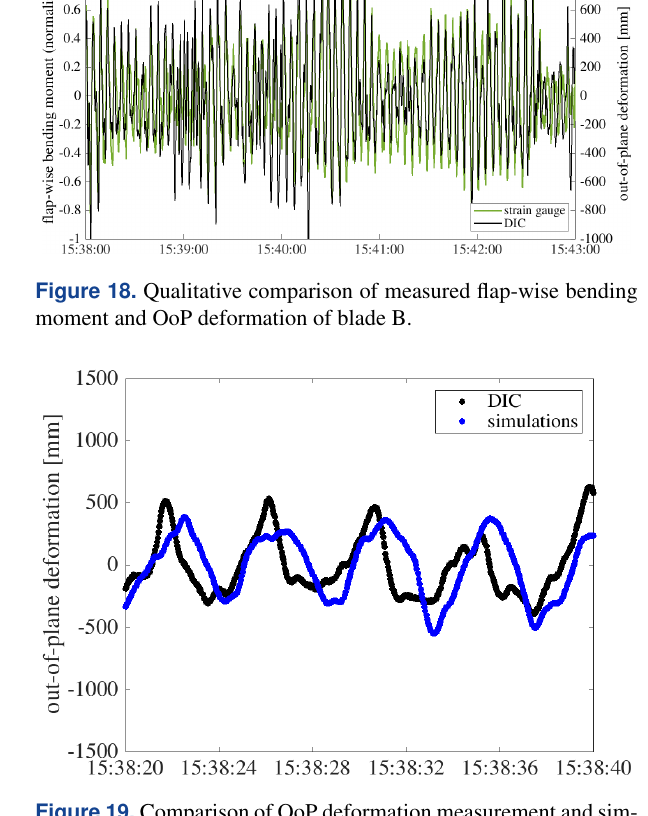
Figure 19. Comparison of OoP deformation measurement and sim- ulations of blade B – short time